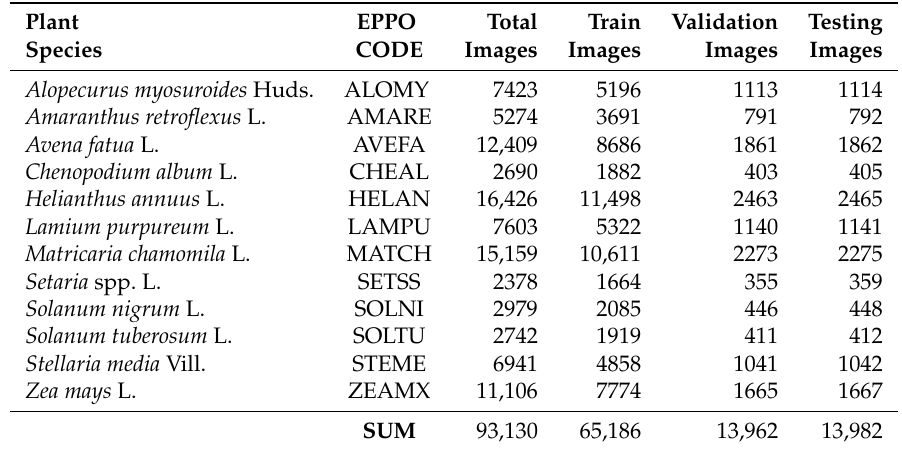
Table 1. Plant species used in the training of the CNNs, the relevant EPPO code, along with the number of labels per plant species in total and for the training, validation and training subset Plant